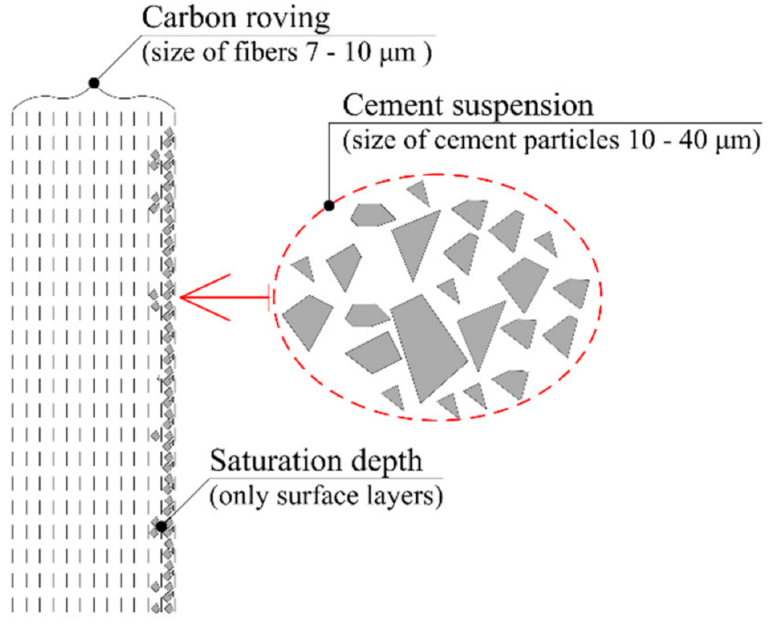
Figure 4. Scheme of carbon roving with cement